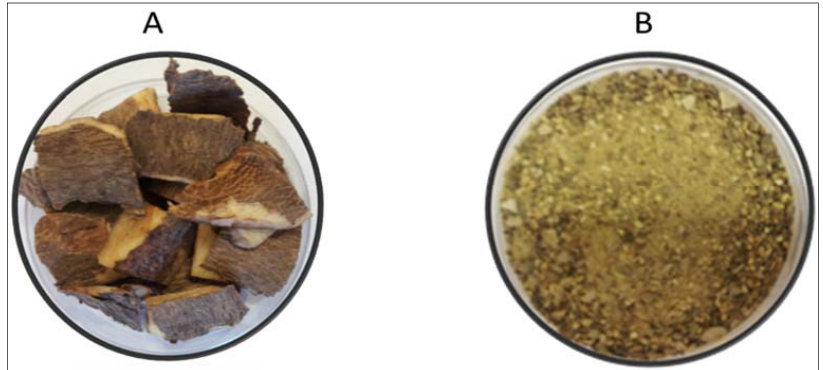
Figure 2. Photograph of raw residue ( A ) and pulverized residue adsorbent ‐ YTBS ( B ).